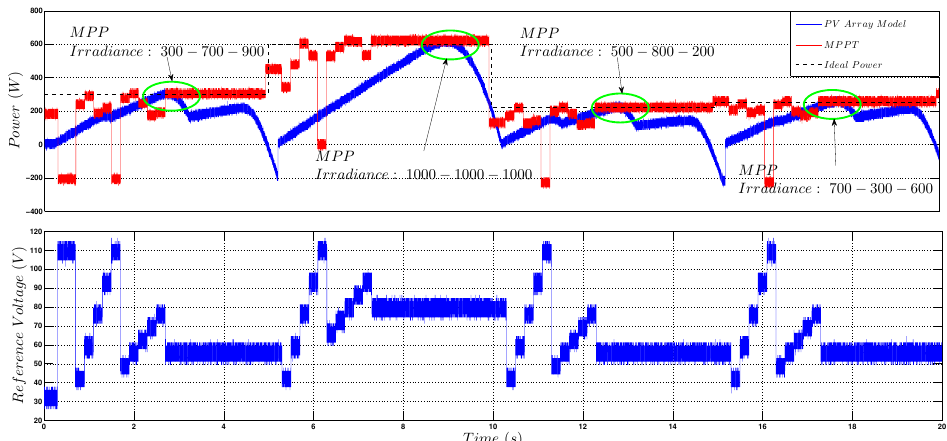
Figure 17. MPPT of the PV panel Kyocera array with curves of the model generated by the speedgoat.